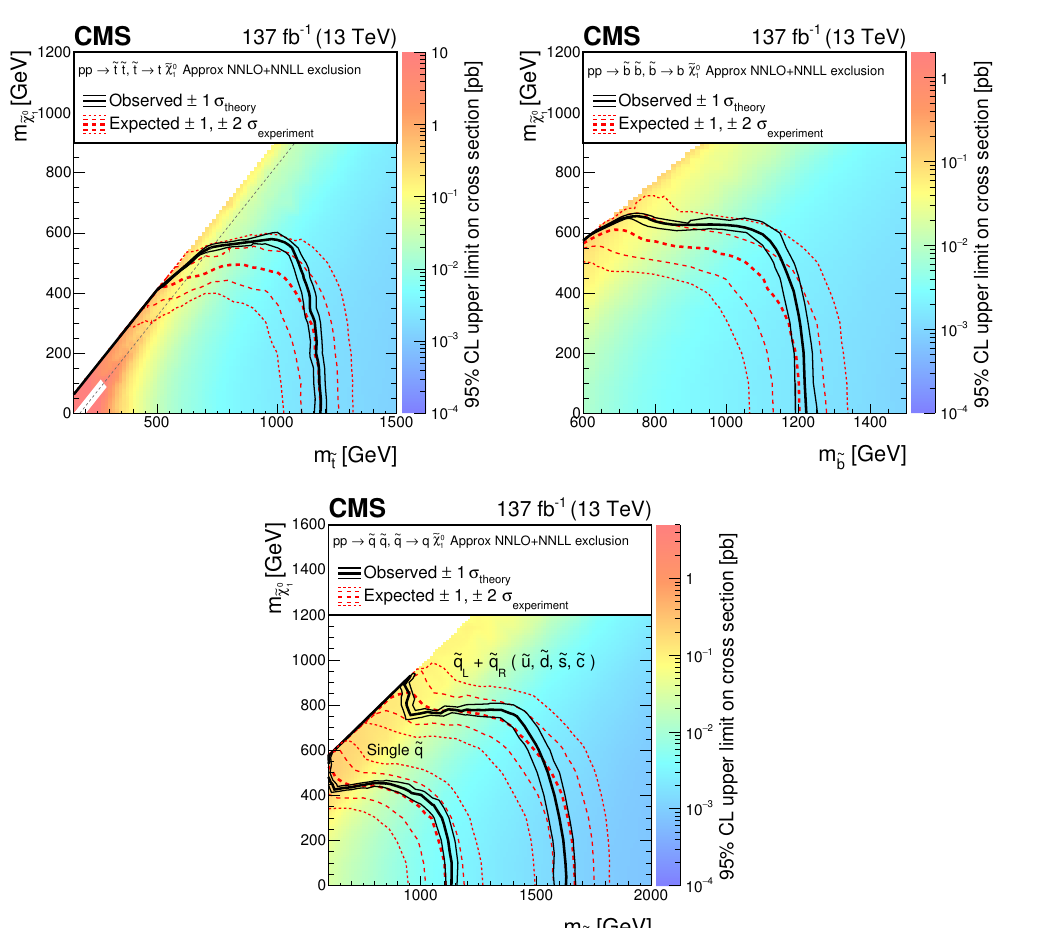
Figure 14 . The 95% CL upper limits on the production cross sections of the (upper left) T2tt, (upper right) T2bb, and (lower) T2qq signal models as a function of the squark and LSP masses m and m . The meaning of the curves is described in the (cid:12)gure 13 caption. For the T2tt model, we 0 1 e (cid:31) do not present cross section upper limits in the unshaded diagonal region at low m discussed in the text. The diagonal dotted line shown for this model corresponds to m